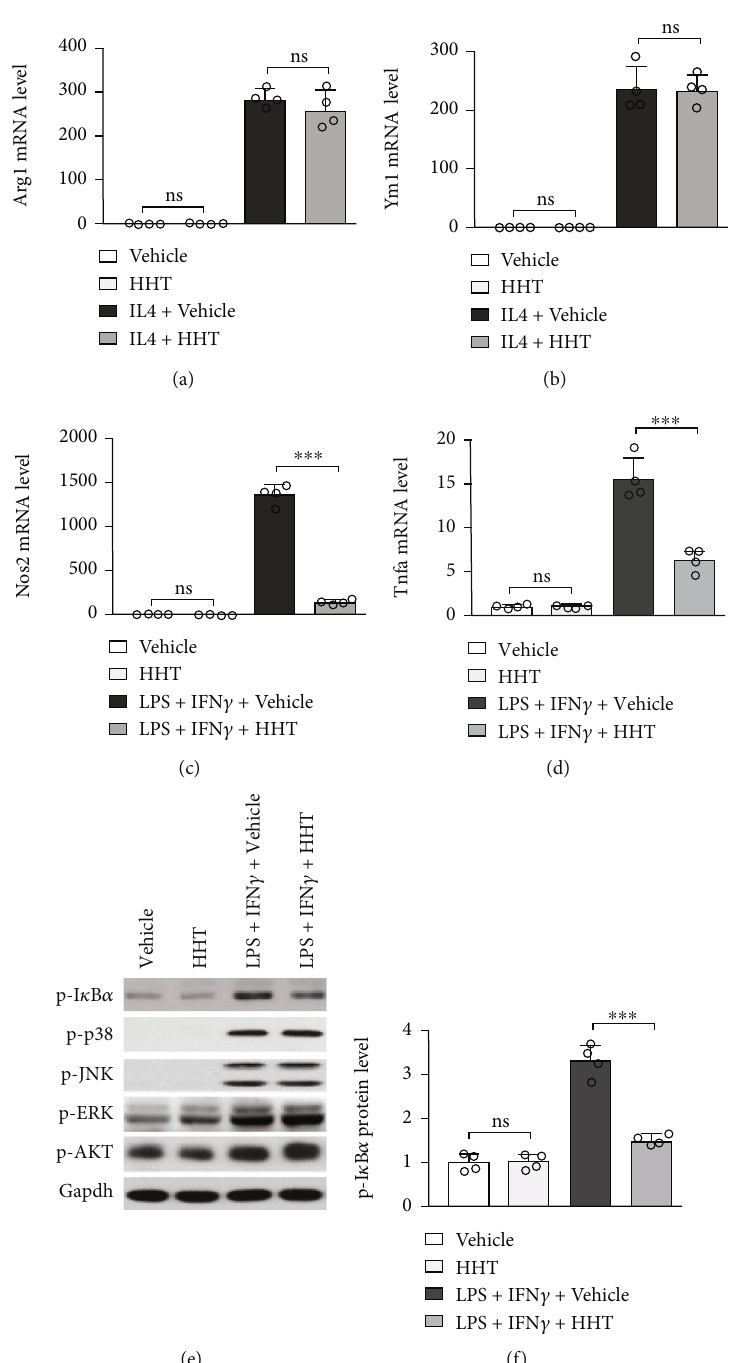
Figure 6: HHT inhibits the M1 polarization of macrophages. (a, b) Peritoneal macrophages were incubated with 50ng/mL recombinant mouse IL4 along with vehicle or 50nM HHT for 24 hours. The mRNA level of Arg1 (a) and Ym1 (b) was analyzed by RT-qPCR. (c, d) Peritoneal macrophages were treated with 100ng/mL LPS and 20ng/mL IFN γ along with vehicle or 50nM HHT for 2 hours. The mRNA level of Nos2 (c) and TNF- α (d) were analyzed by RT-qPCR. (e, f) Peritoneal macrophages were stimulated with 100 ng/mL LPS and 20 ng/mL IFN γ along with vehicle or 50nM HHT for 15min. The protein level of p-I κ B α (e, f), p-AKT, p-JNK, p-p38, and p-ERK (e) was analyzed by Western blot. Error bar represents mean ± SD . ∗∗∗ p < 0 : 001 ; ns: not signi fi